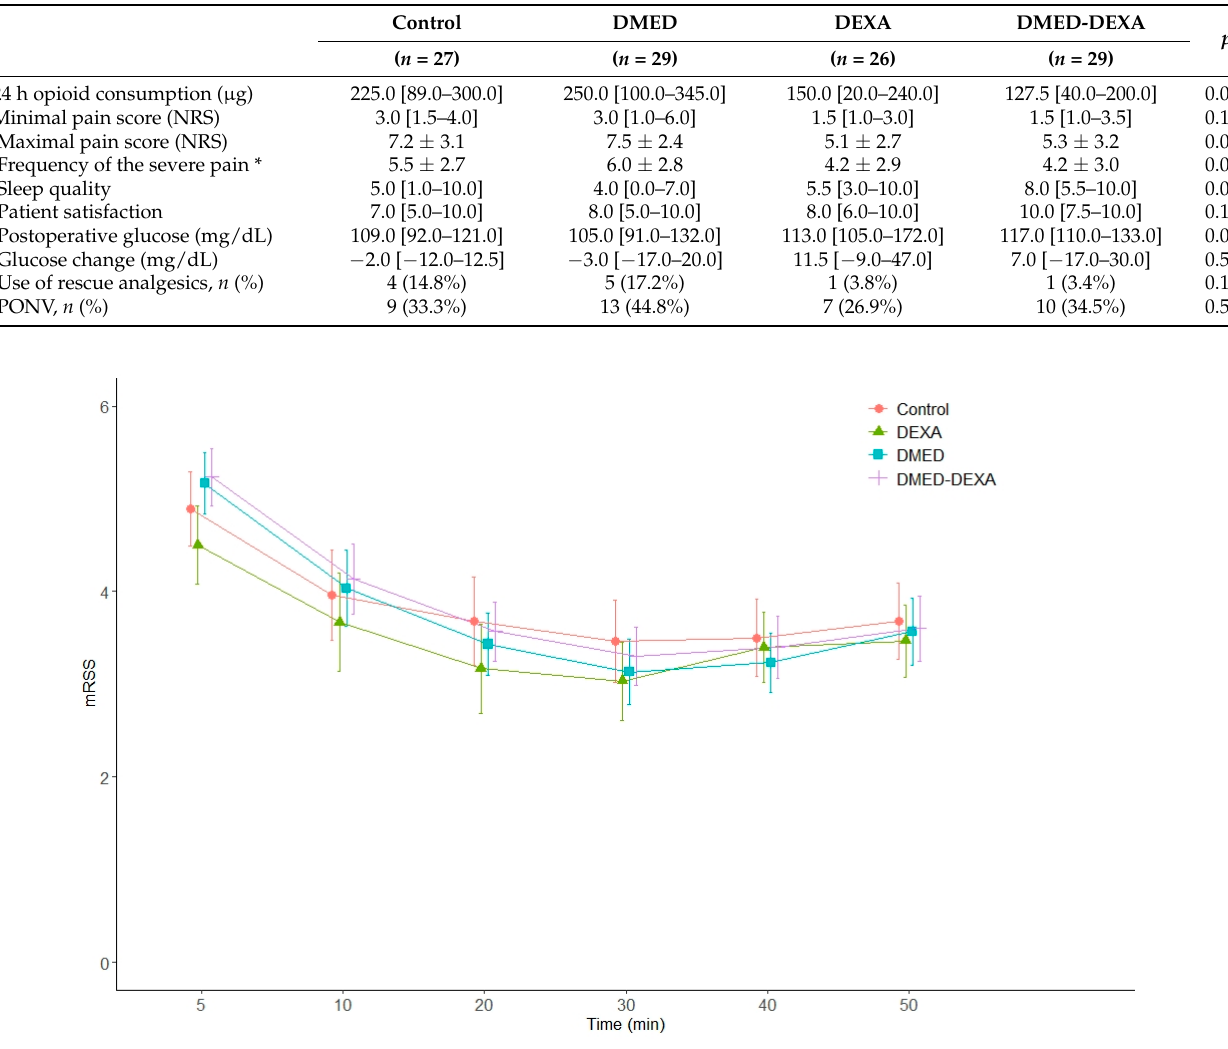
Table 2. Secondary outcomes. Data are presented as median [IQR], mean ± SD or number (%). * Pain during the first 24 h postoperatively rated on a 10-point scale, from 0 for no severe pain to 10 for consistent perception of severe. NRS, numeric rating scale; PONV, post-operative nausea and vomiting.